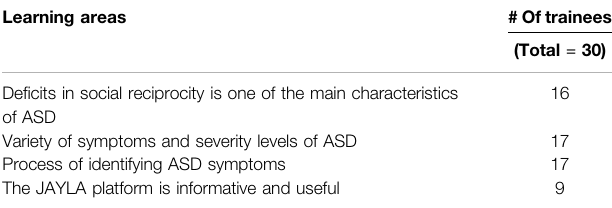
TABLE 4 | Summary of learning areas from qualitative results. Learning